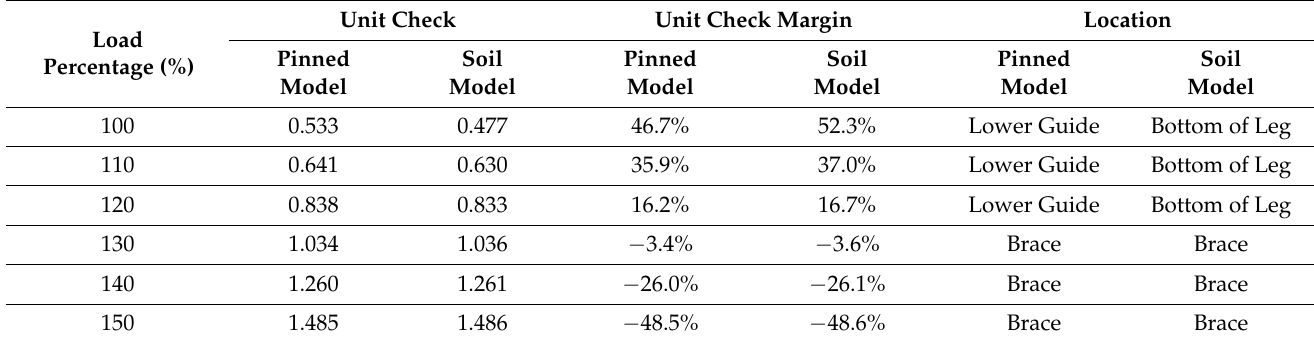
Table 5. Effect of structural response according to parameters for wave height.